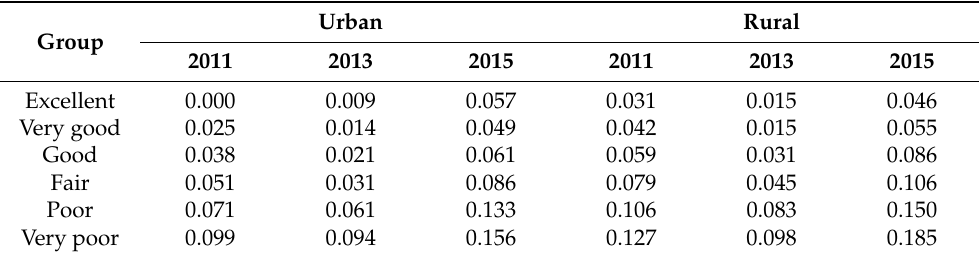
Table 3. Households’ financial vulnerability by health status of household heads. Urban Rural Group